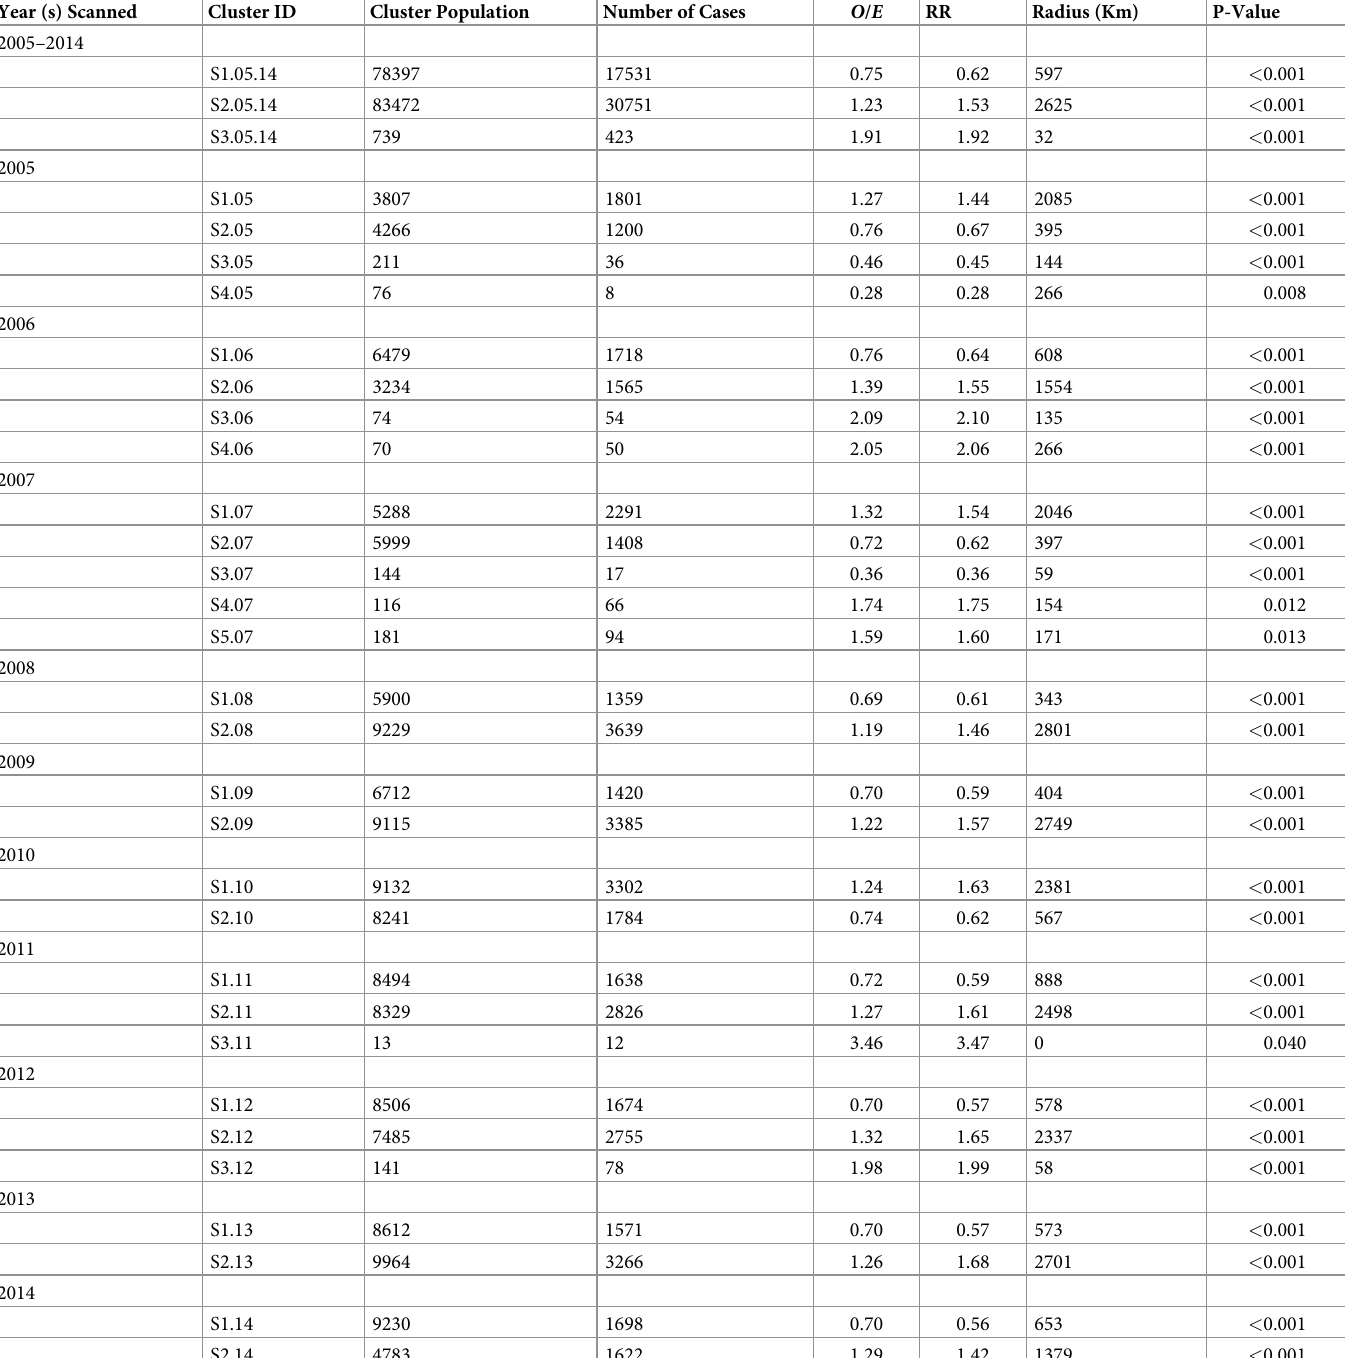
Table 2. Statistically significant clusters of high and low proportion of veterinarian calls relative to public calls from purely spatial scans for the entire study period (2005–2014) and each individual year �